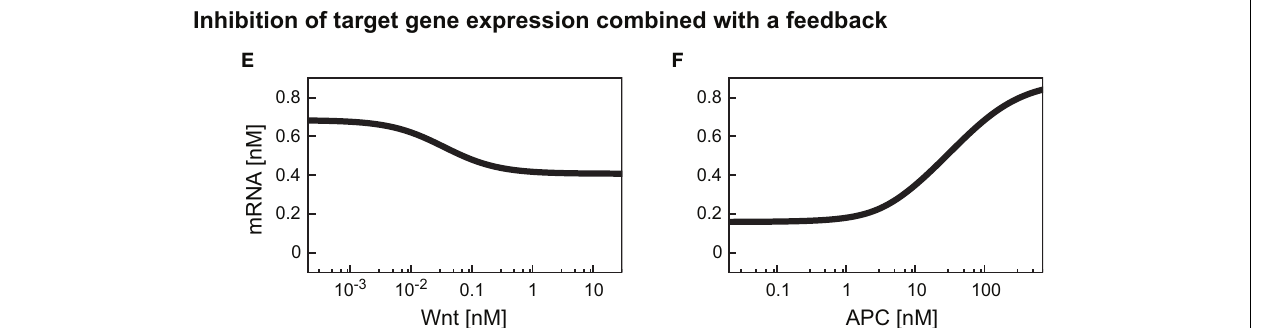
FIGURE 8 | Steady state responses of differently regulated target genes in the presence of aTCF feedback. Steady state responses of target genes regulated by an iFFL motif (A,B) , in a cooperative manner with the Hill